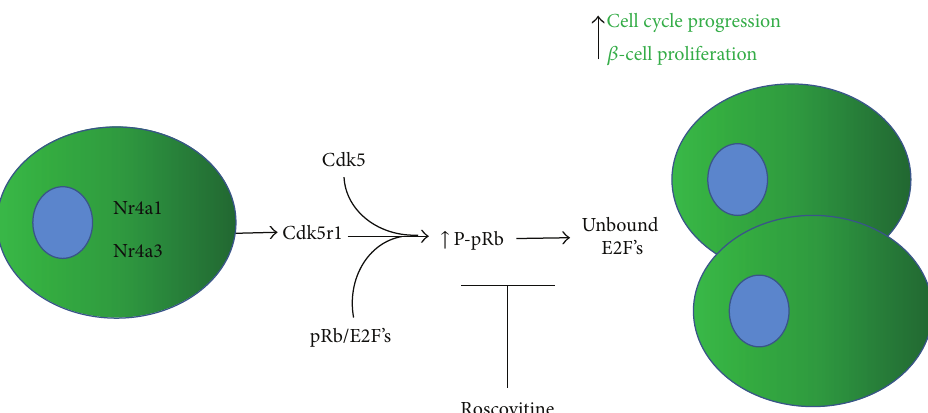
Figure 9: Model of how Cdk5r1 induces 𝛽 -cell proliferation. Overexpression of Nr4a1 or Nr4a3 induces expression of Cdk5r1 in primary rat 𝛽 -cells. Cdk5r1 forms a complex with Cdk5, thus activating the Cdk5 kinase. The Cdk5r1/Cdk5 kinase complex phosphorylates pRb. In the unphosphorylated state pRb binds and sequesters E2F family members, thus inhibiting cell cycle progression. Upon phosphorylation of pRB, E2F family members are released and permitted to induce expression of cell cycle genes that are sufficient to induce proliferation. The Cdk5 kinase inhibitor roscovitine blocks phosphorylation of pRb and inhibits Cdk5r1 induced 𝛽 -cell